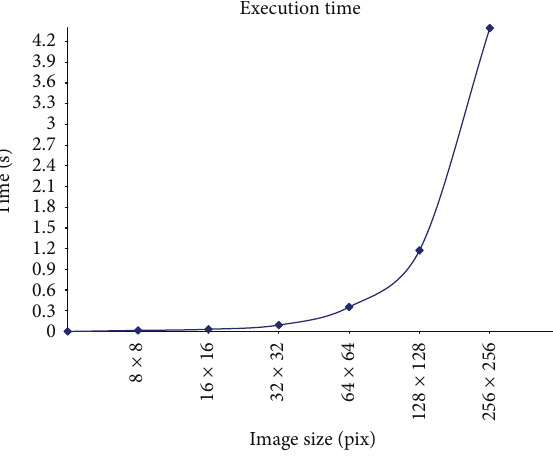
Figure 10: Execution time analysis of the phase-based approach based on the image resolution (in